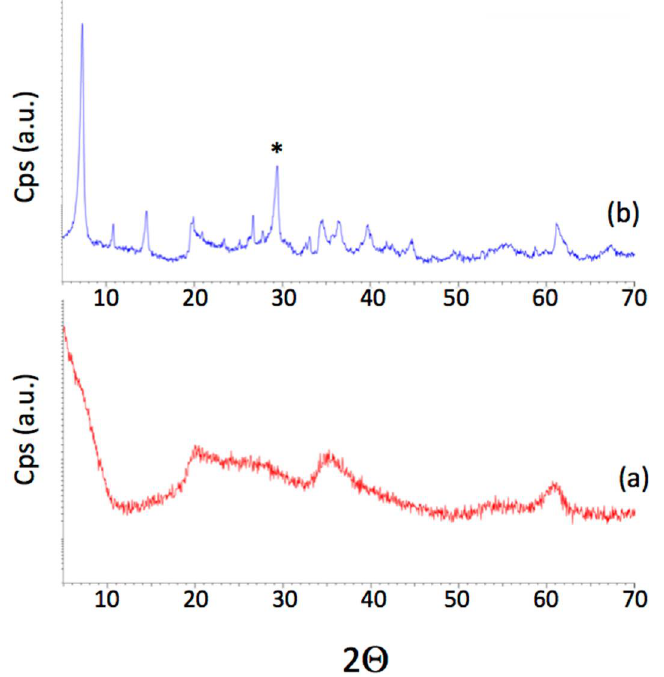
Figure 1. XRD patterns of several synthesized clays ( a ) delaminated hectorite (Na-DH) and ( b ) Li-fluorohectorite (Li-FH). * anthophyllite.